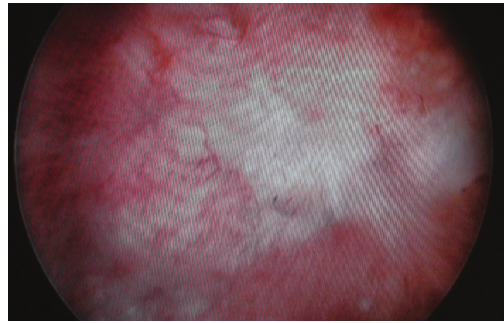
Figure 2: Preoperative cystoscopic evaluation of the resection area showing the rectal lumen following an iatrogenic rectal injury.